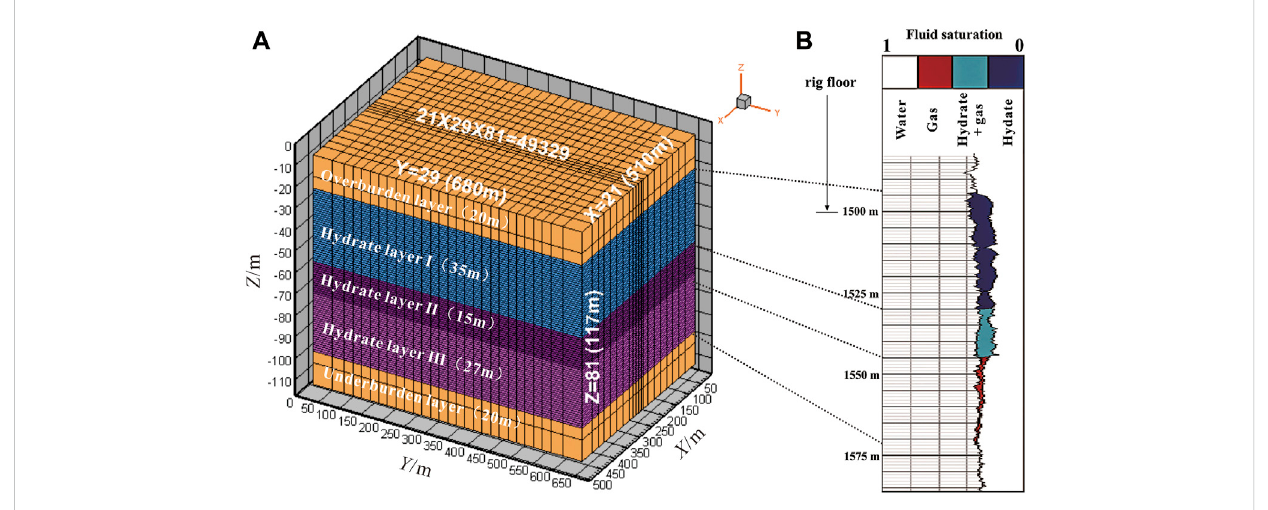
FIGURE 2 Model mesh (A) . Logging curve of well SHSC-4 (B) (Li et al.,